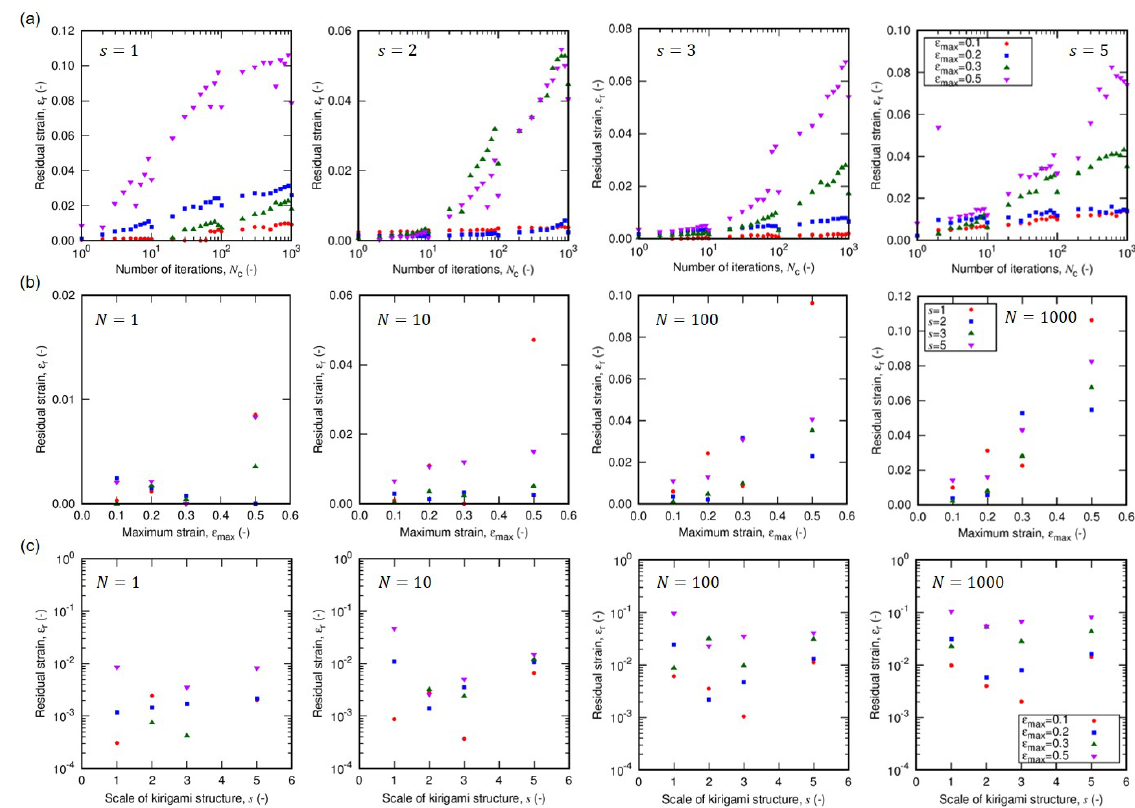
Figure 4. The residual strain as a function of ( a ) the number of tensile loading cycle, ( b ) the maximum strain in a cycle, and ( c ) the unit scale s of Kirigami structure. The parameter “ s ” is defined in the Section